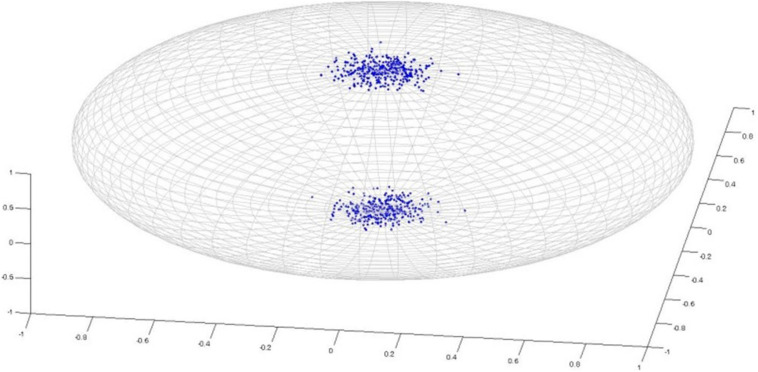
Watson Distribution.